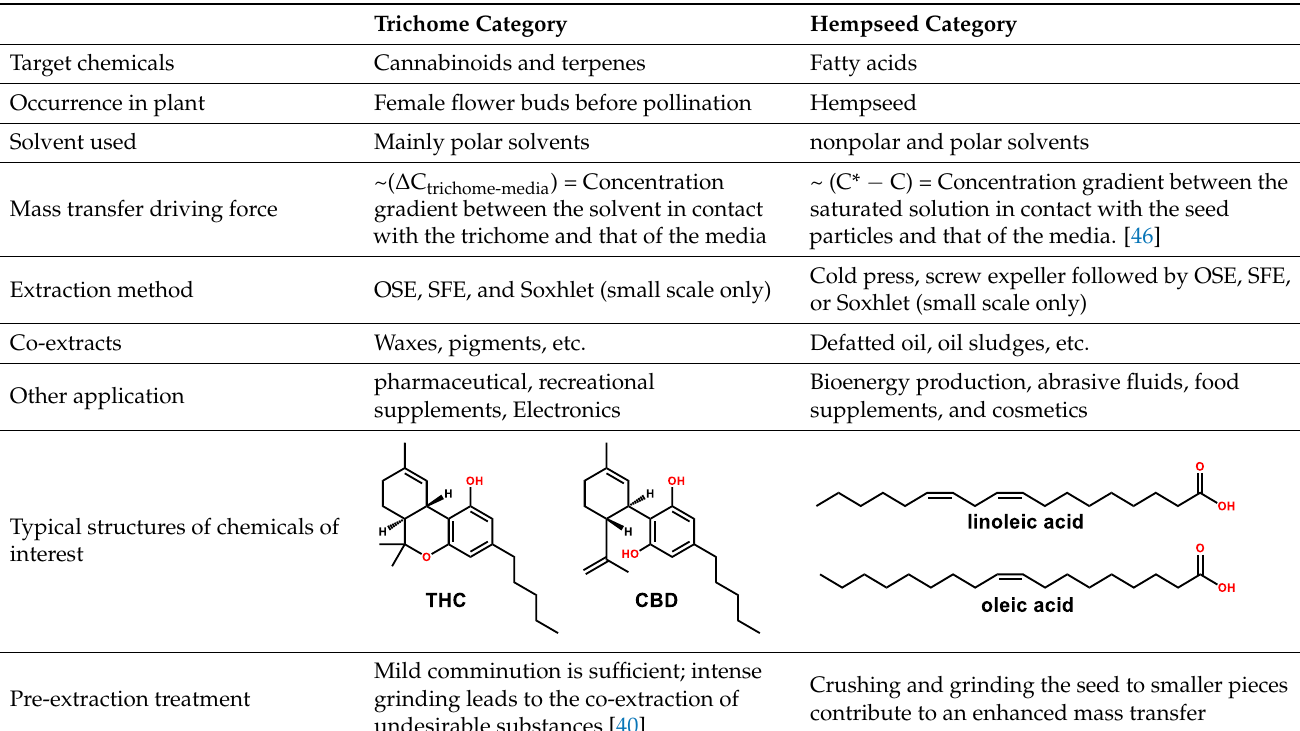
Table 1. Two categories where extraction takes place in the hemp